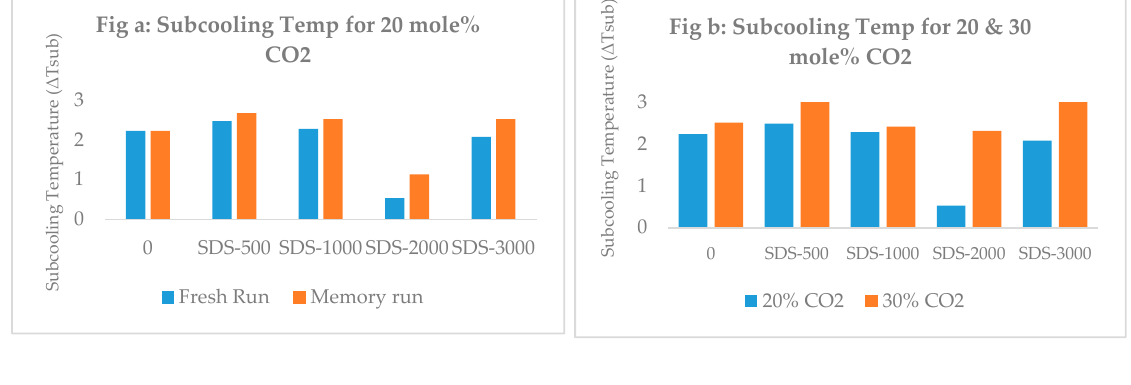
Fig:d Subcooling Temp for 20 & 30 Fig:c Subcooling Temp for 20 mole% CO2